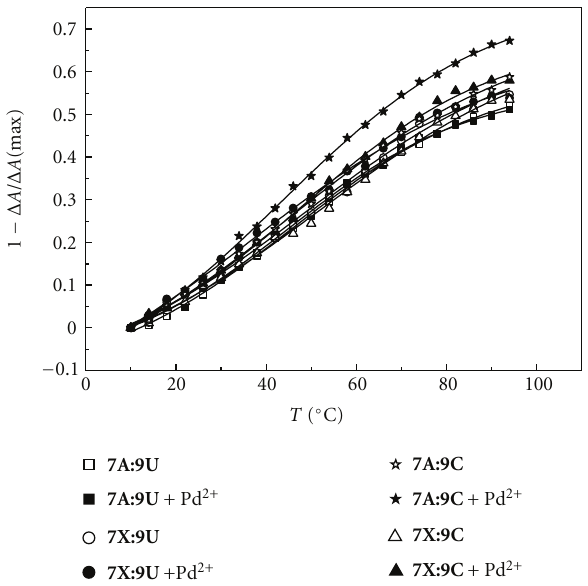
Figure 7: Temperature versus 1 − Δ A / Δ A (max) profiles of the duplexes of the modified oligonucleotide 7X or 7A with oligori- bonucleotide 9U and 9C in the presence and absence of Pd 2+ ; [oligonucleotides] = 3.0 μ M, [K 2 PdCl 4 ] = 0/3.0 μ M, scan range 220– 320nm; I (NaClO 4 ) = 0.1 molL − 1 ; pH =